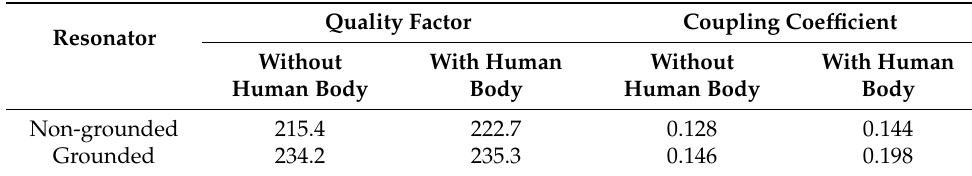
Table 2. Quality factor and coupling coefficient of the MRC-WPT systems for two types of resonators, d = 9 cm. Quality Factor Resonator